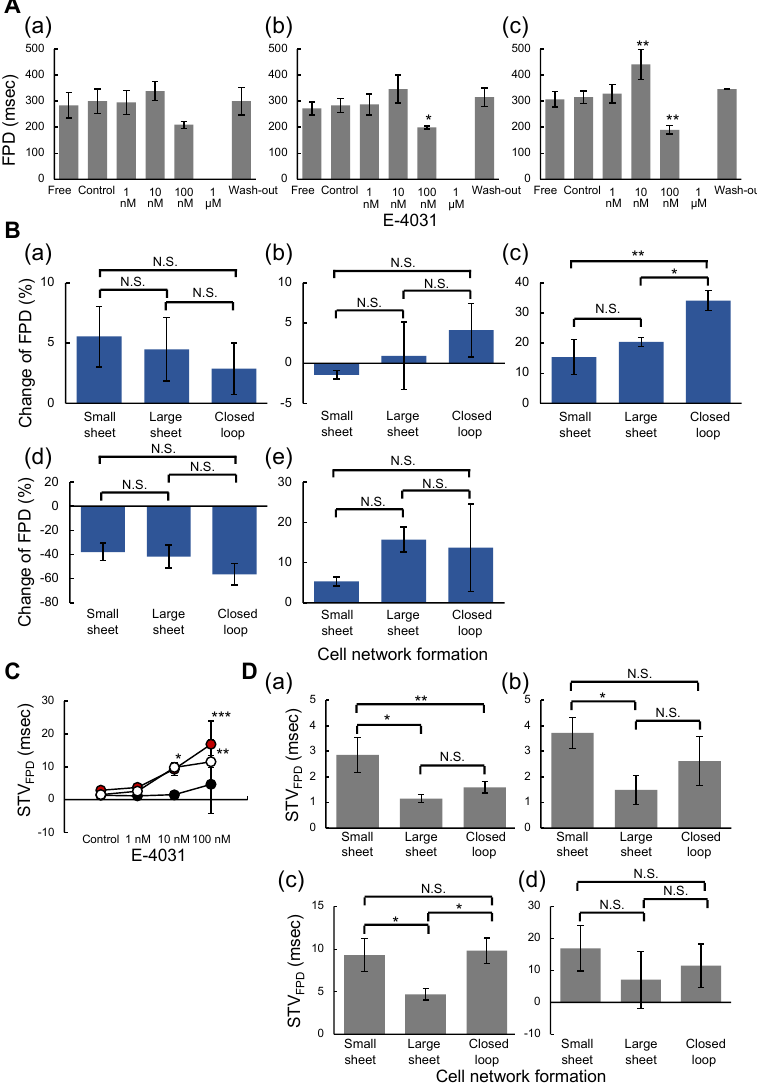
Figure 6. Evaluation of hERG ion channel blocking on field potential duration time prolongation in three types of cardiomyocyte network patterns. ( A ): E-4031 concentration dependence of field potential duration (FPD) time: ( a ) small sheet (n = 3), ( b ) large square sheet (n = 3), and ( c ) large square closed-loop sheet (n = 3). Bars, mean values. Error bars, S.D. Dunnett’s multiple comparison test, * p < 0.05 and ** p < 0.01 vs. Control state. ( B ): Change in FPD in three cardiomyocyte network patterns: ( a ) Free to Control (n = 3 each), ( b ) Control to Low (n = 3 each), ( c ) Low to Medium (n = 3 each), ( d ) Medium to High (n = 3 each), and ( e ) Free to Wash-out (n = 3 each). Tukey’s multiple comparison test, * p < 0.05 and ** p < 0.01. ( C ): Short-term variability (STV) of FPD values against E-4031 concentration. The red, black, and open circles indicate mean STV values of the small, large square, and square closed-loop groups, respectively (n = 3 each). Dunnett’s multiple comparison test, * p < 0.05, ** p < 0.01, and *** p < 0.001 vs. Control state. ( D ): STV of FPD in three cardiomyocyte network patterns: ( a ) Control state (n = 3 each), ( b ) Low state (n = 3 each), ( c ) Medium state (n = 3 each), and ( d ) High state (n = 3 each). Bars, mean values. Error bars, S.D. Tukey’s multiple comparison test, * p < 0.05 and ** p <